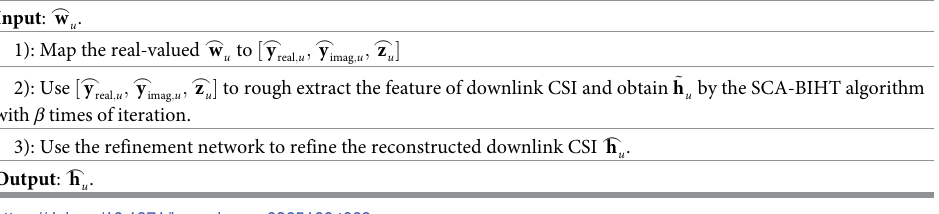
Table 3. Procedure of reconstruction network.